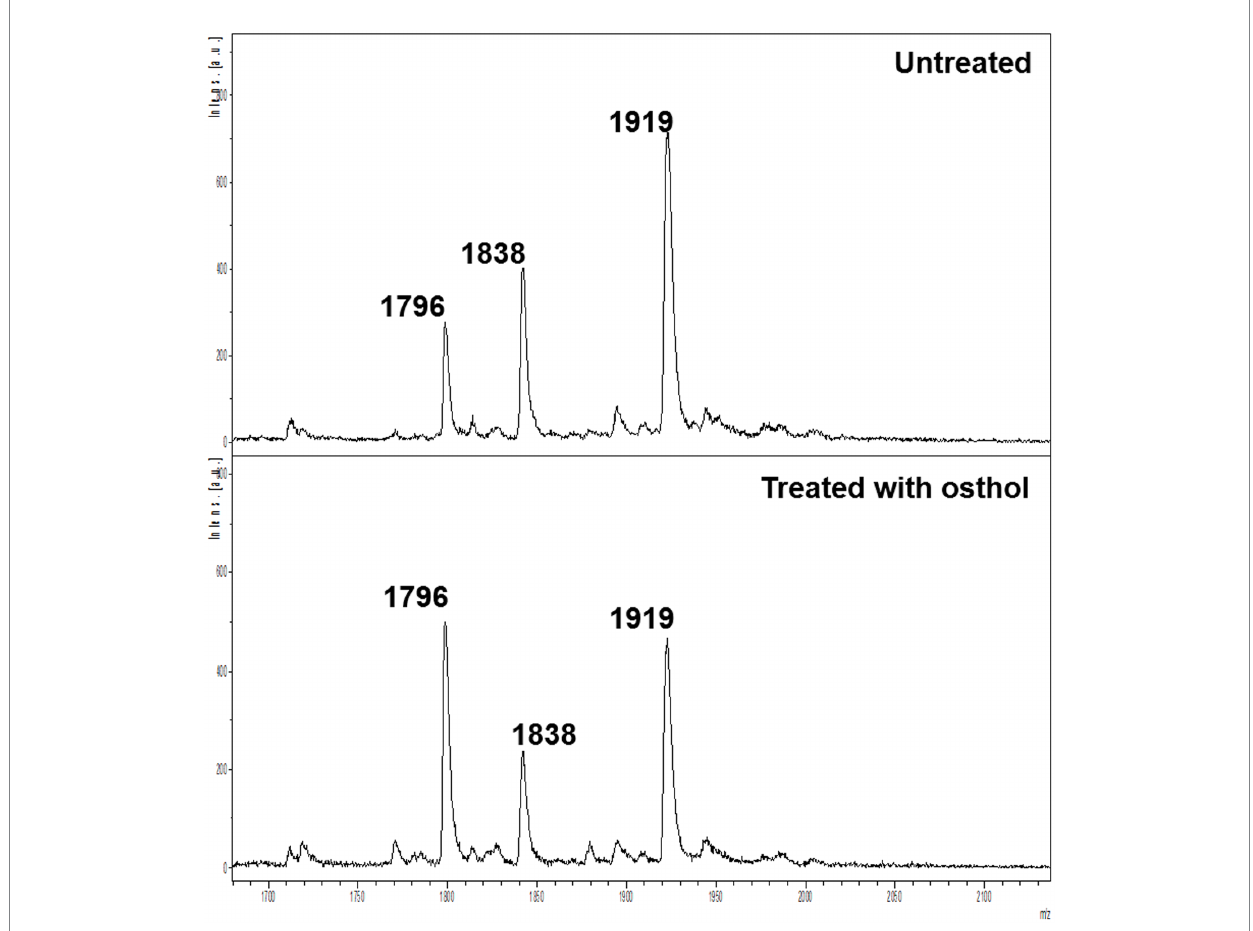
FIGURE 2 Mass spectra of untreated E. coli J53 mcr-1 (top) and E. coli J53 mcr-1 treated with 64 μ g/ml osthol